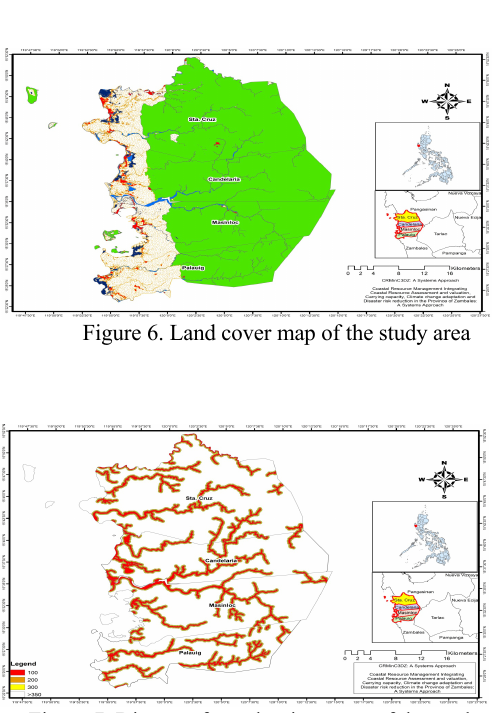
Figure 7. Distance from the river map of the study area Table 1 shows the scoring of attributes for flood susceptibility index of the study area. The five factors (slope, soil type, land cover, distance from the river, and elevation) were reclassified into 0, 1, 2, and 3 depending on their degree which can influence flooding.